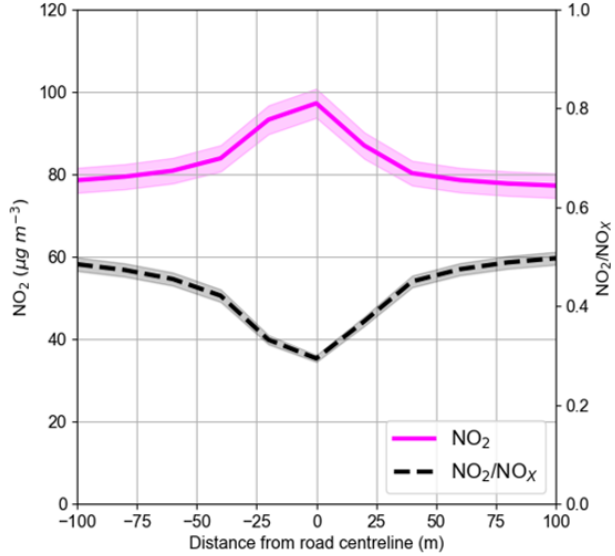
Figure 5. Simulated campaign period mean NO 2 concentrations, with distance from the point on the Second Ring Road centre line (marked by X in Fig. 4c) using MEIC Opt (pink). Simulated NO 2 / NO x ratio denoted by a black dashed line. Shaded areas rep- resent the 95% confidence